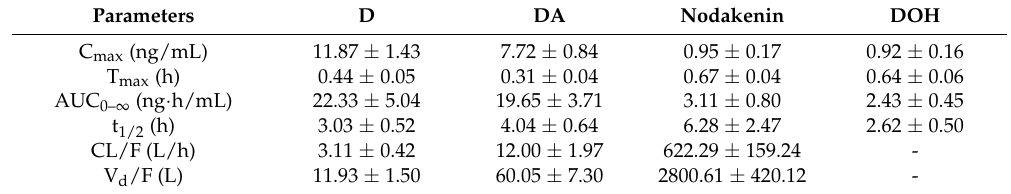
Table 3. Pharmacokinetic parameters for D, DA, nodakenin, and DOH in humans after a usual oral dose administration of 4.6 g of AGN extract powder (mean ± SE, n =